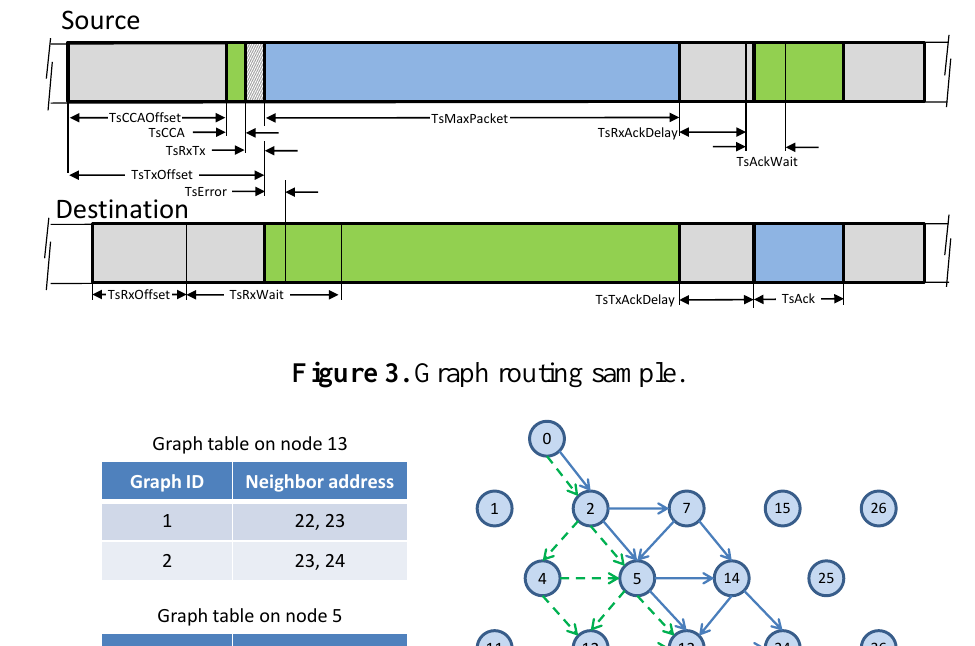
Figure 2. Timing of a dedicated TSCH timeslot.